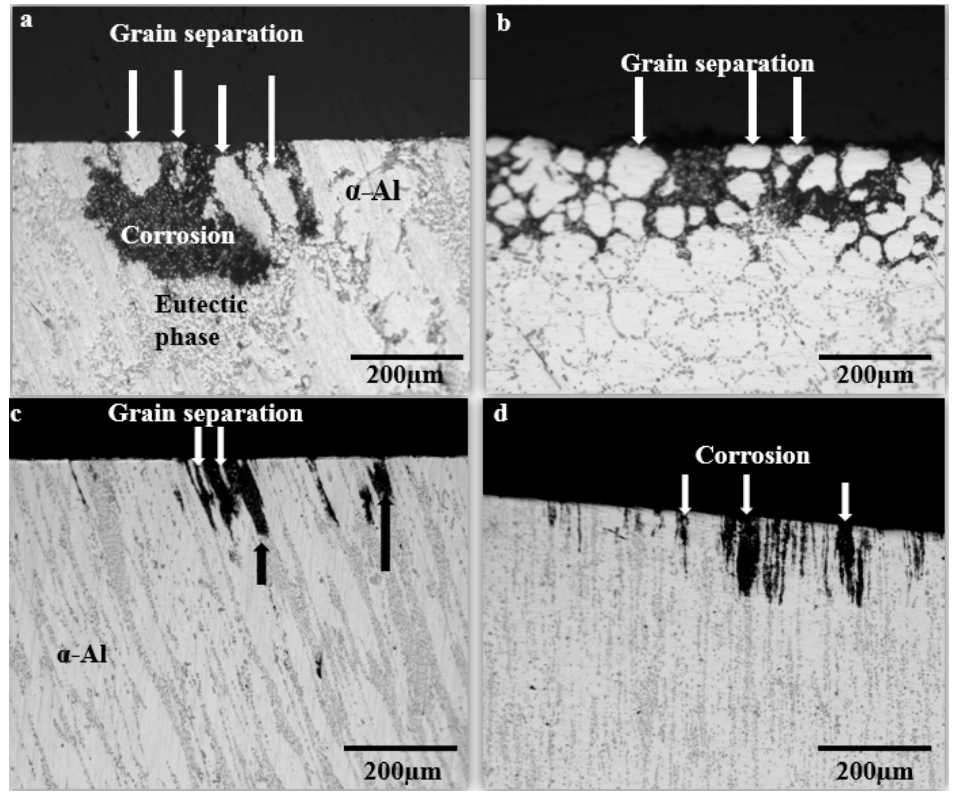
Figure 9. Pitting corrosion of ( a ) as-cast, ( b ) cooling slope, ( c ) as-cast-T6,4 passes and ( d ) cooling slope-T6, 6 passes route A of A356 alloy.